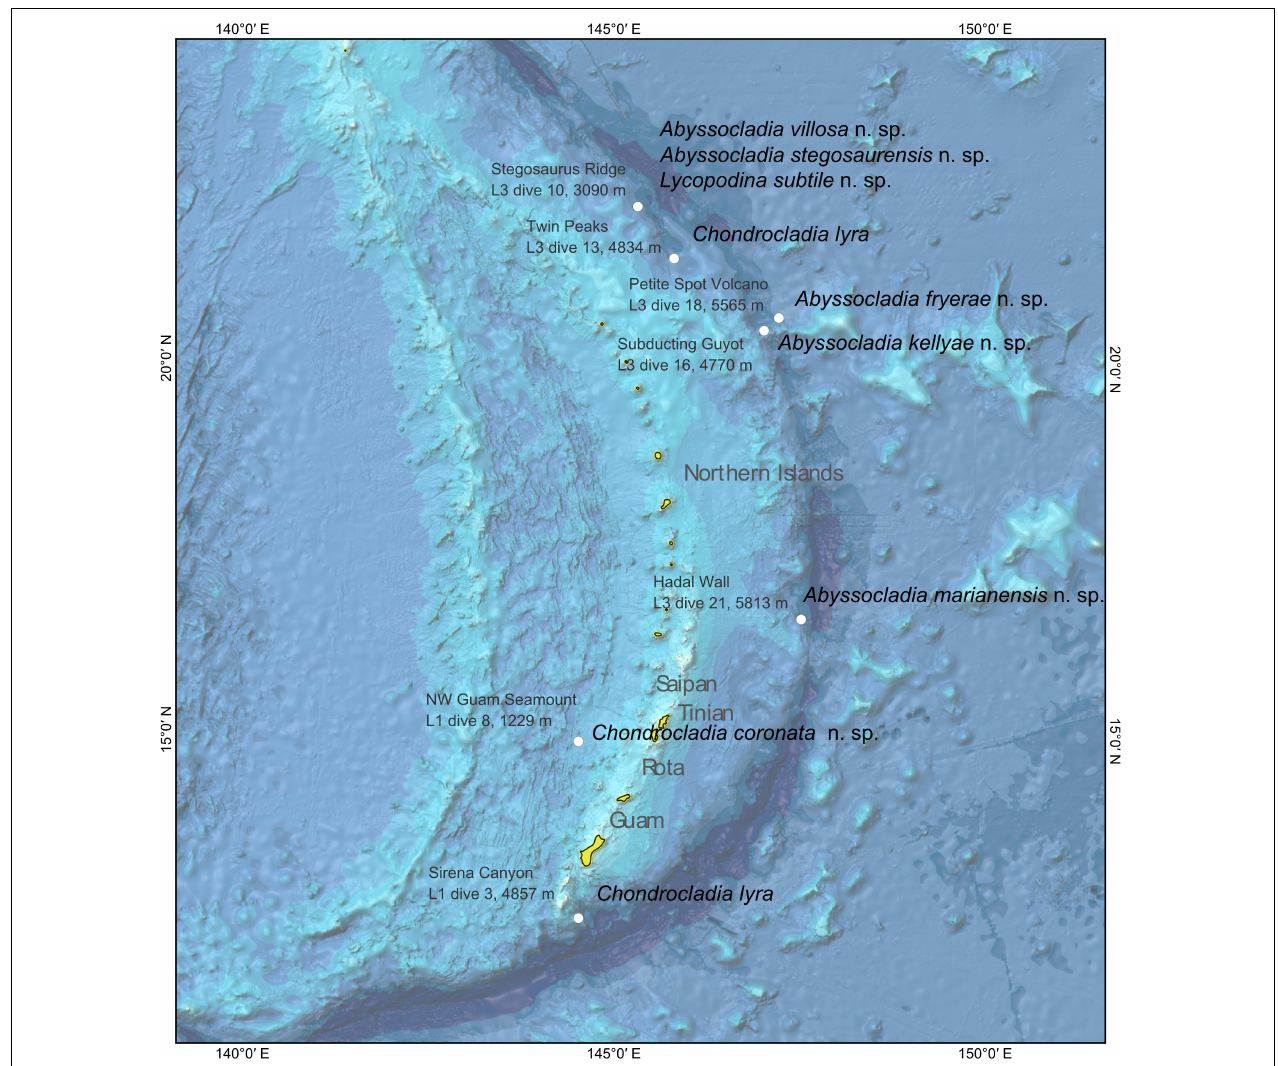
FIGURE 1 | Bathymetric map of the sea floor around the Mariana Islands with collection localities for the species in this study.